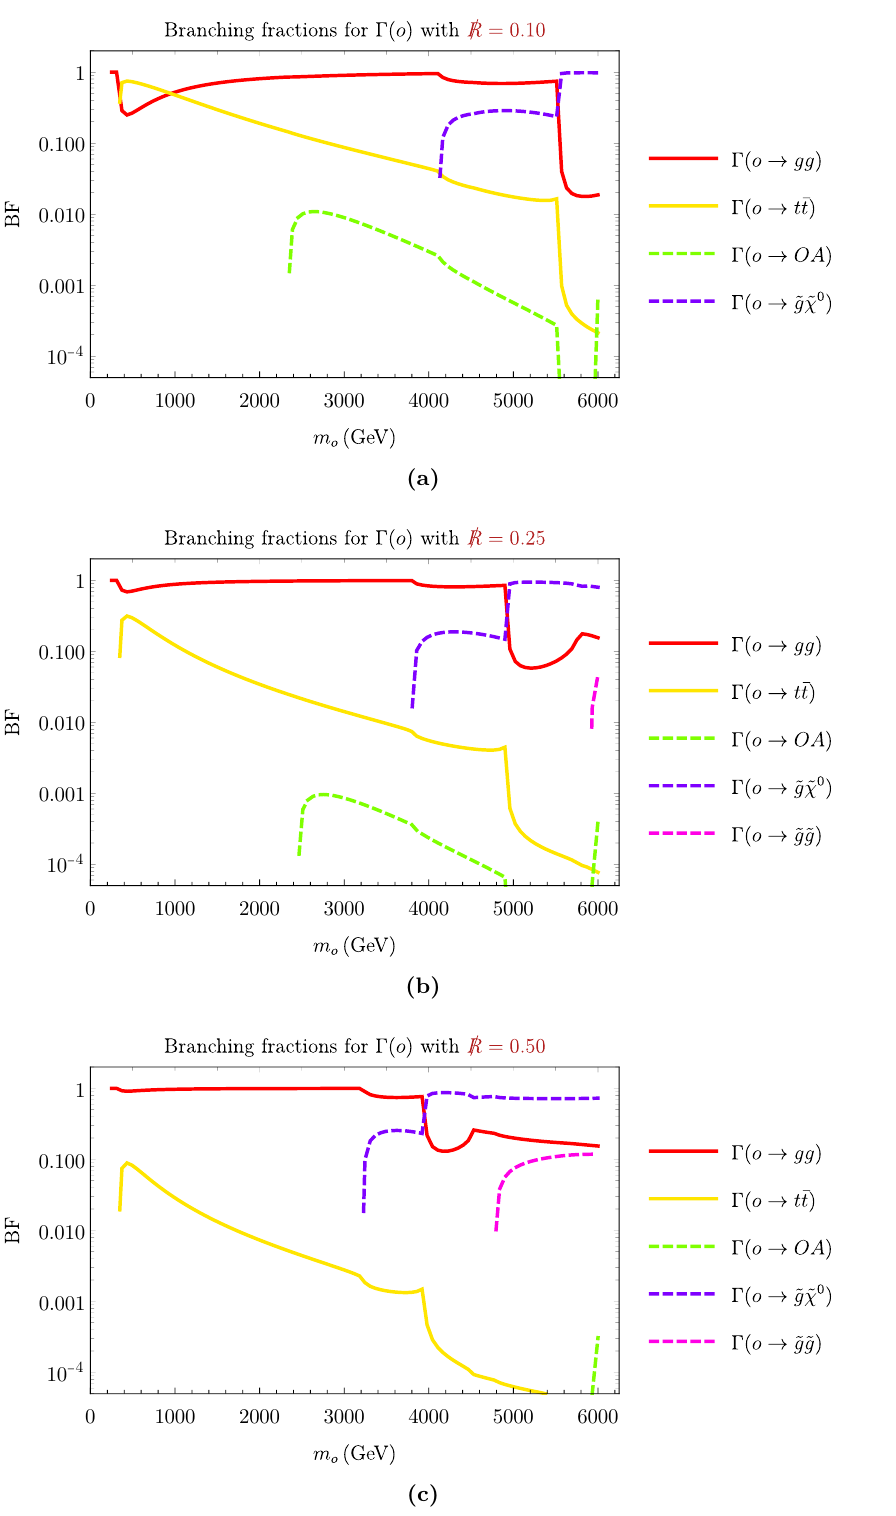
Figure 8. Branching fractions for the pseudoscalar sgluon in (a) Benchmark 1, with /R = 0.10 ; (b) Benchmark 2, with / R = 0.25 , and (c) Benchmark 3, with / R = 0.50